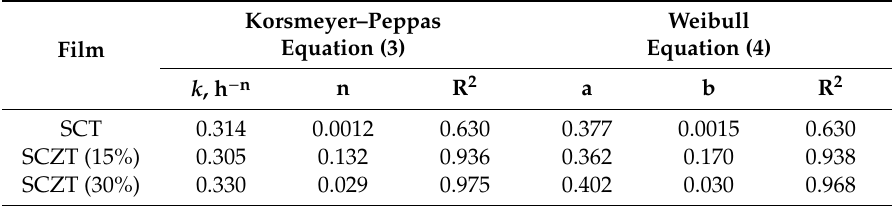
Figure 6. Relative mass of thymol released from SCT film with 10.08% of thymol, SCZT (15%) with 16.7% of thymol and SCZT (30%) with 24% of thymol. Table 3. Parameters and correlation coe ffi cients (R 2 ) of the release kinetics